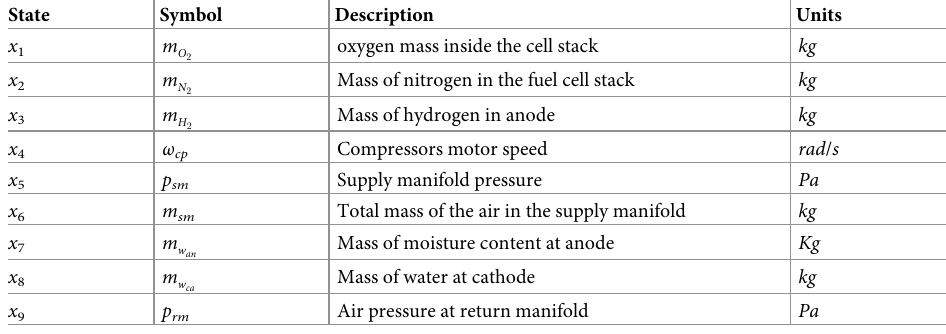
Table 1. Description of state variables.